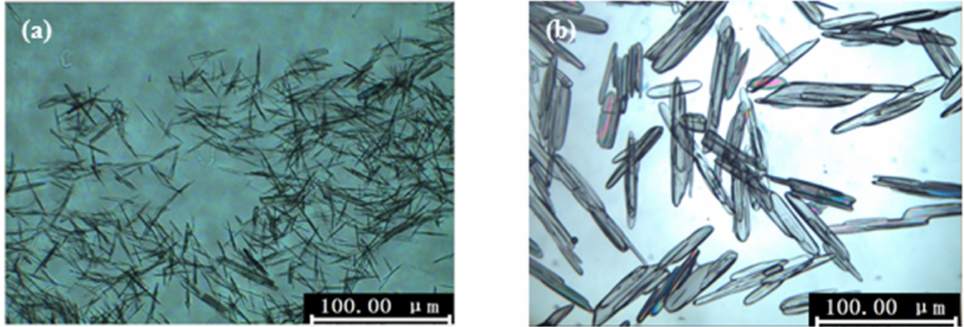
Figure 4. Polymorphic morphology of L-carnosine in a polarizing microscope: ( a ) form I; ( b ) form